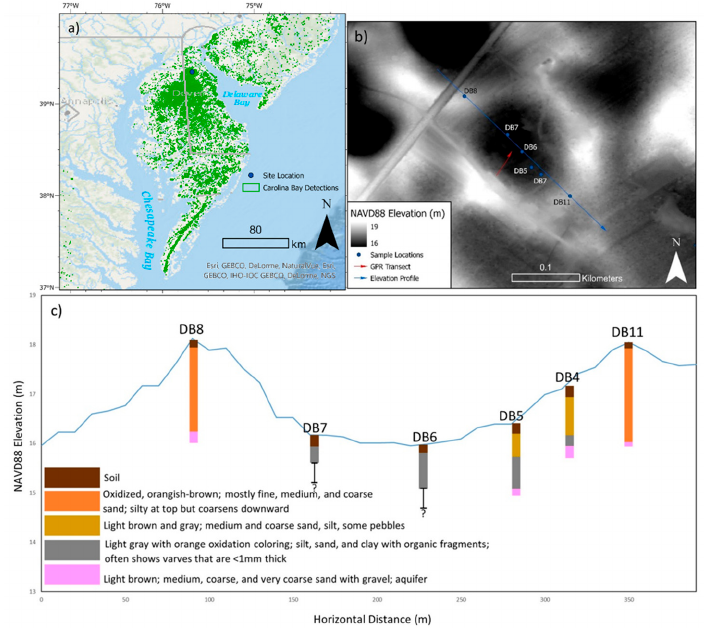
Figure 21. Profile of hand auger samples with descriptions taken at a Carolina Bay in Delaware. ( a ) Broader geographic location. ( b ) Location of samples plotted on a DEM. ( c ) Cross-section with sediment descriptions.